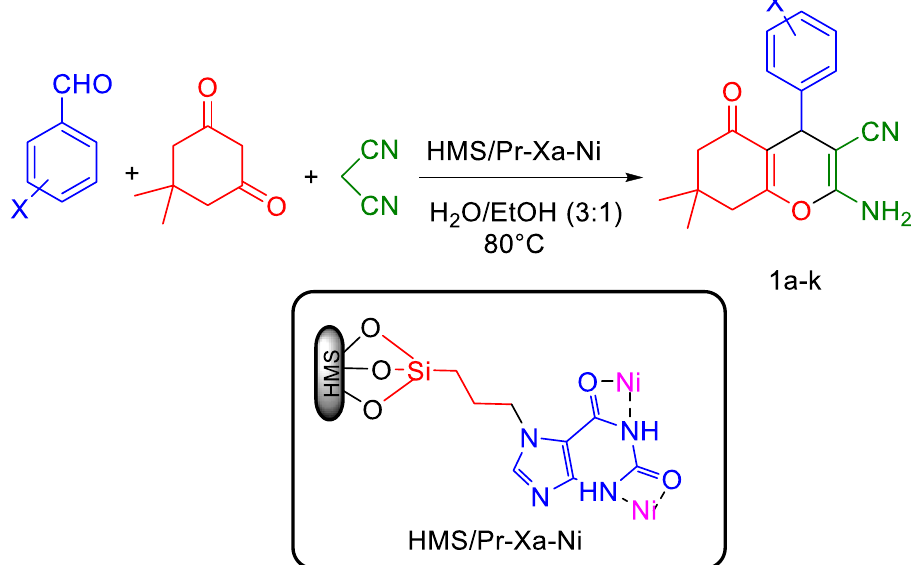
Figure 19. General procedure for the synthesis of tetrahydrobenzo[b]pyran.